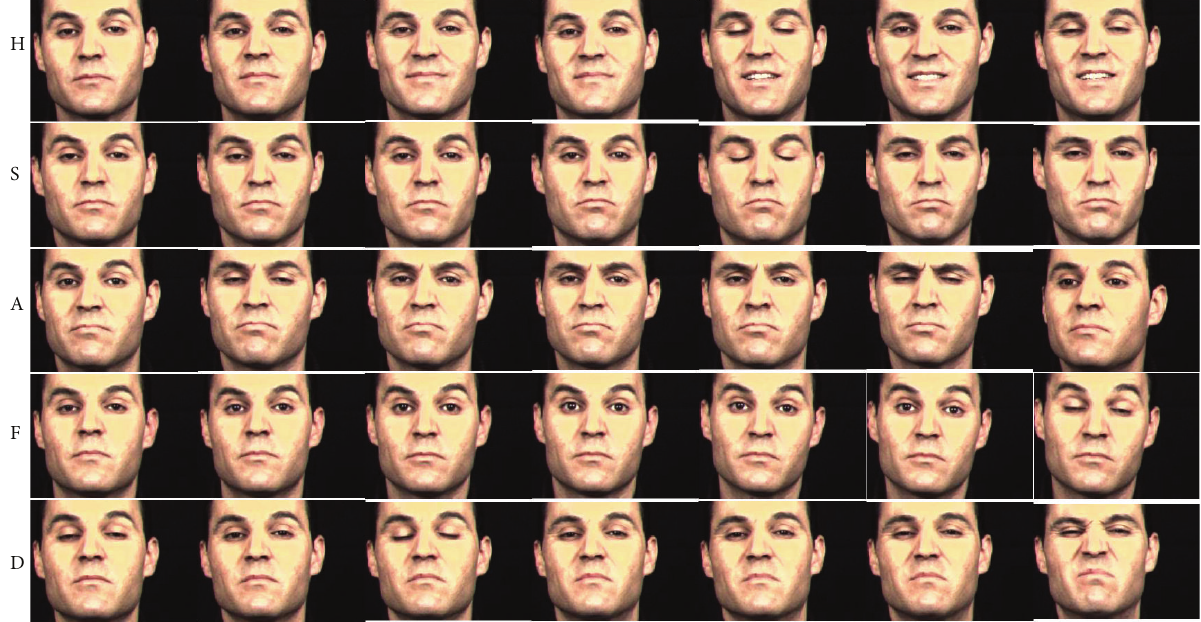
Figure 2: Sample videos of a subject with low ambiguity and high distinctiveness . H, S, A, F, and D stand for happiness, sadness, anger, fear, and disgust. Each row shows sample images evenly chosen from a video of the emotion. Facial expressions of low ambiguity and high distinctiveness are consistent within each emotion and also different across emotions, which makes each emotion well recognizable.